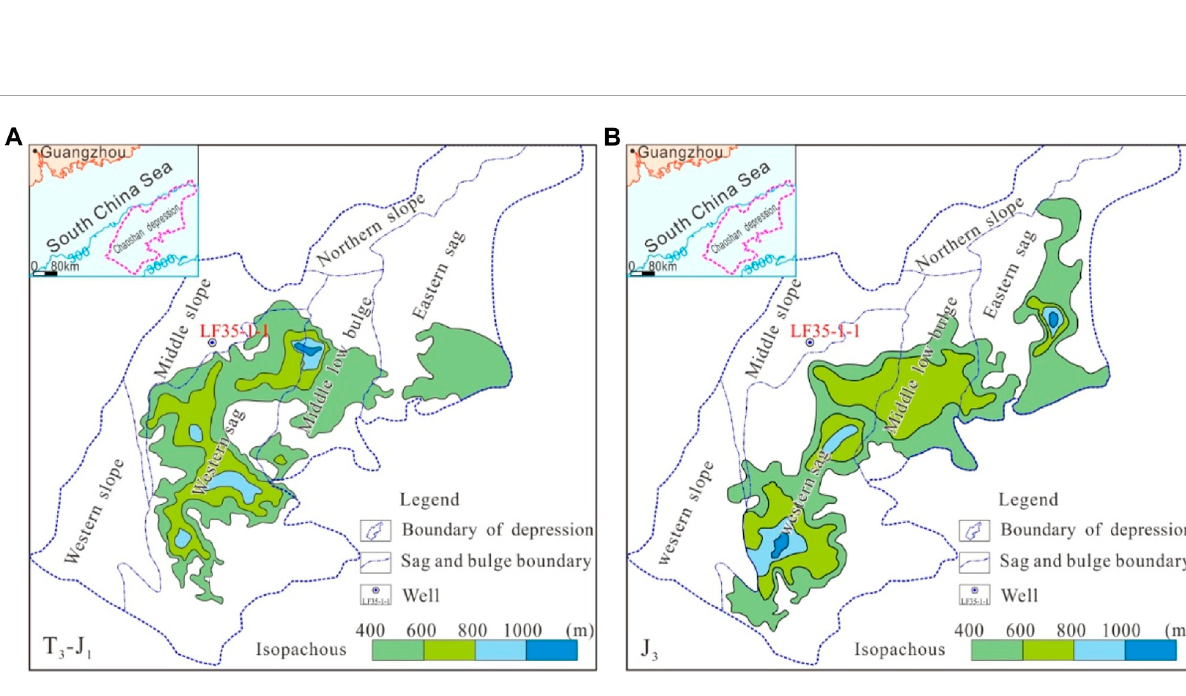
Frontiers in Earth